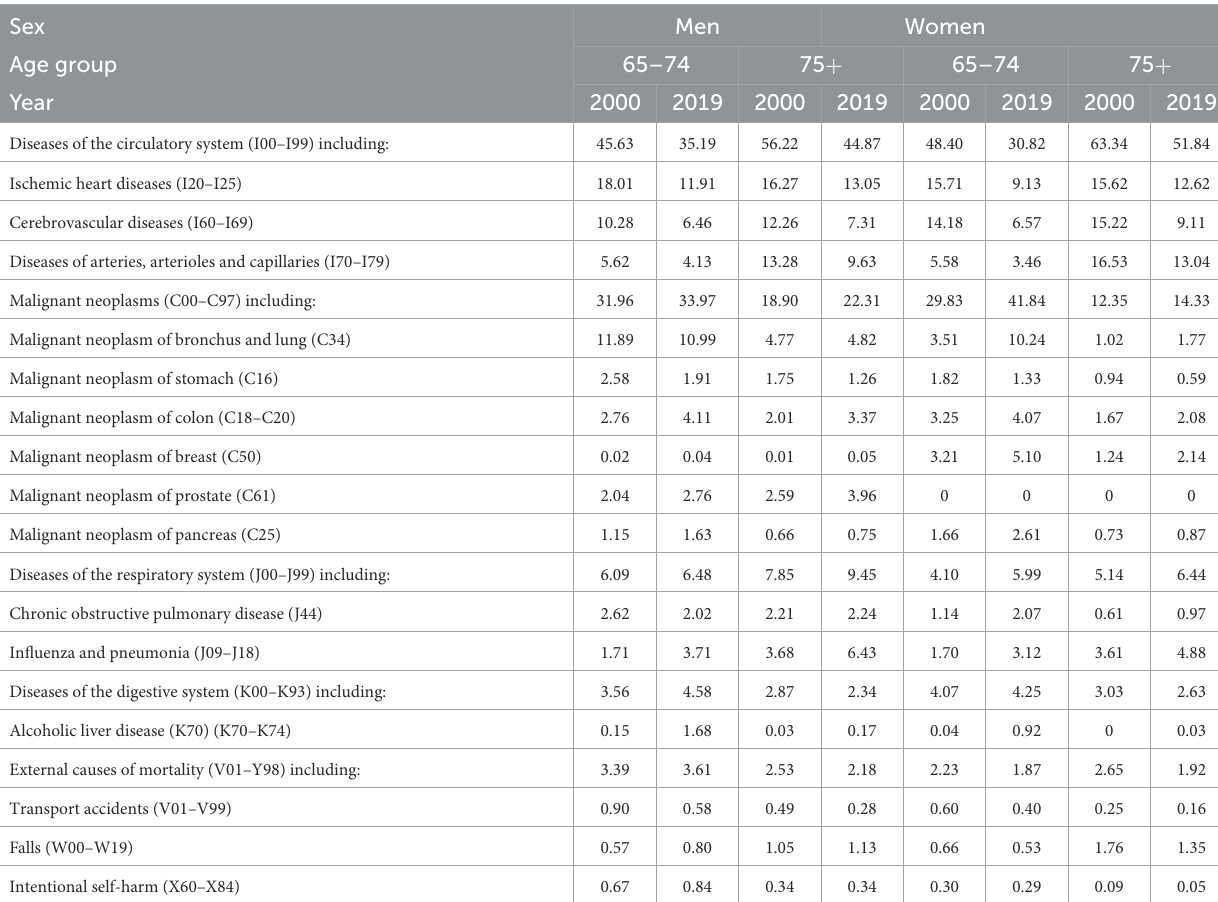
TABLE 1 Percentage of deaths from the most common causes of death by gender in the groups aged 65–74 years and 75 years and older in 2000 and 2019. Sex Men Women Age group 65–74